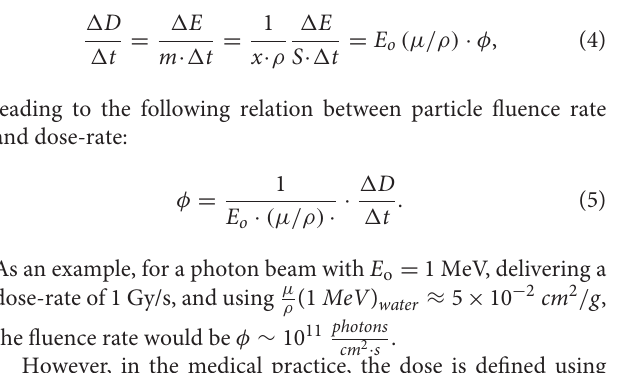
approximated evaluation of the orders of magnitude involved in the FLASH irradiations